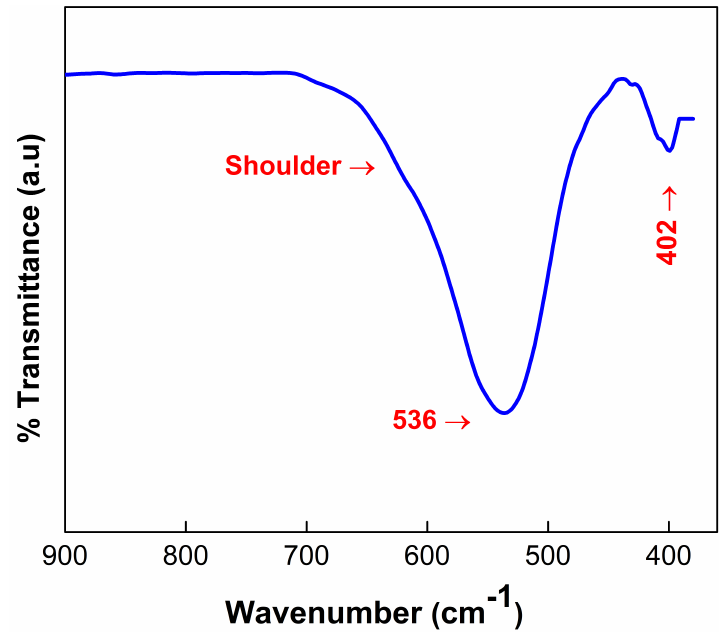
Figure 3. FT-IR absorption spectrum for the Cu 0.75 Co 0.25 Fe 2 O 4 ferrite nanoparticles recorded at RT and in the range of 370–900 cm − 1